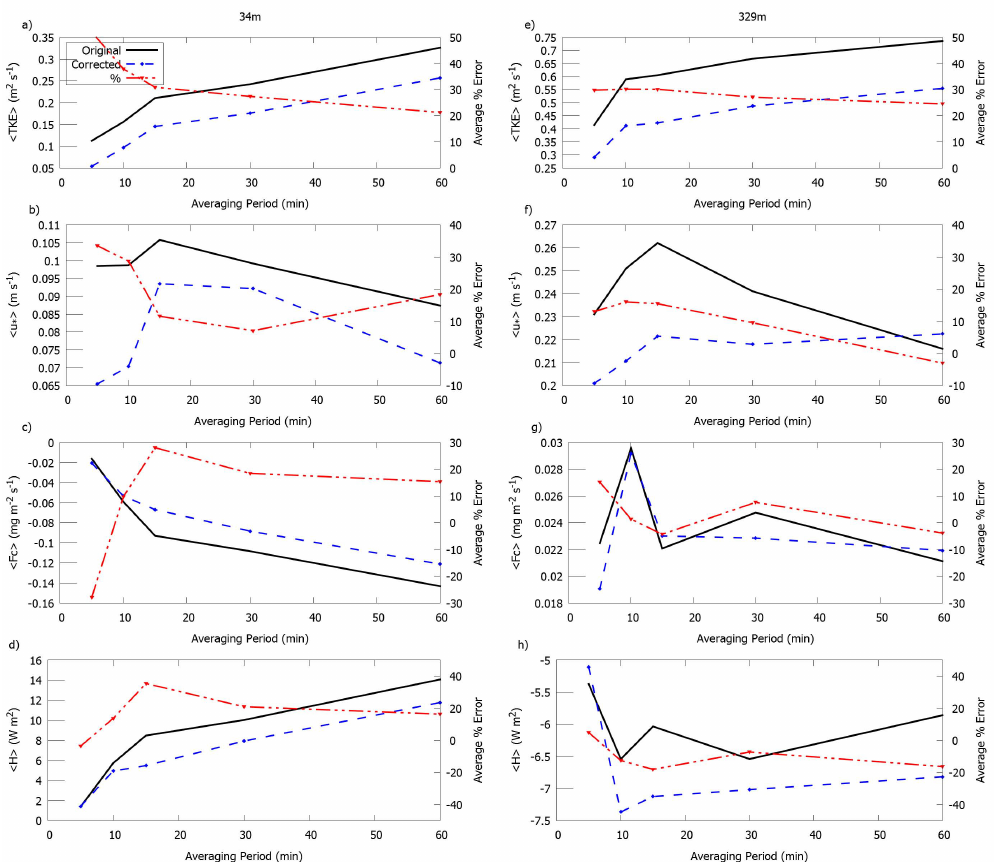
Fig. 5. Average turbulent kinetic energy <TKE> (a, e) , friction velocity < u ∗ > (b, f) , CO 2 flux < F c > (c, g) , and sensible heat flux <H> (d, h) for the “original” (solid) and “corrected” (dashed) time series during the wave event on 23 April 2009 at the 34 and 329m levels on the tall tower are depicted using different averaging periods. The average percent error (dot-dashed) introduced by the absence of such corrections is also